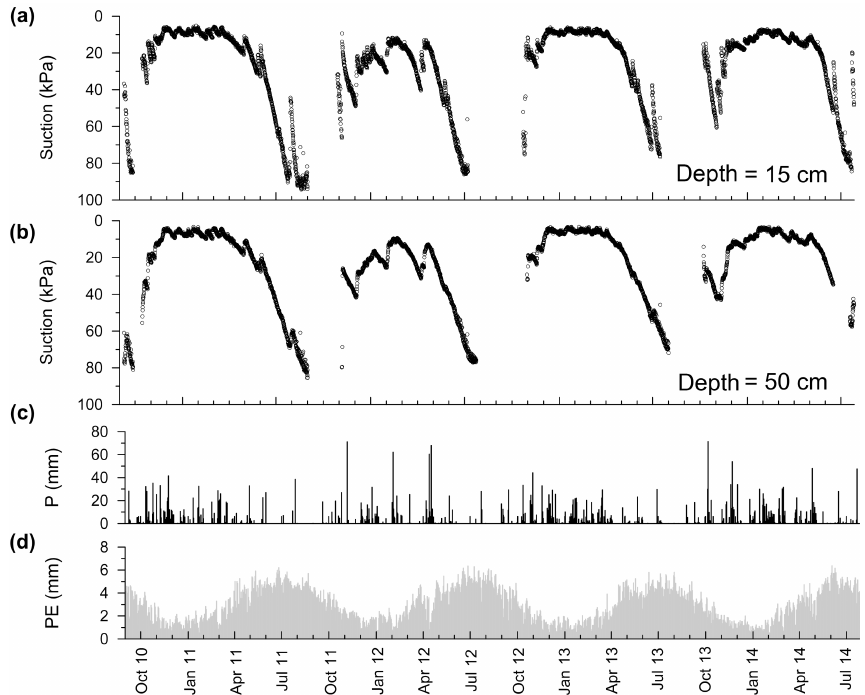
Figure 6. Evolution of variables recorded by the physical model of lysimeter: (a) matric suction at depth of 15cm; (b) matric suction at depth of 50cm; (c) daily precipitations ( P ); (d) daily potential evaporation (PE). (Over the first 2 hydrological years records are from Rianna et al.,